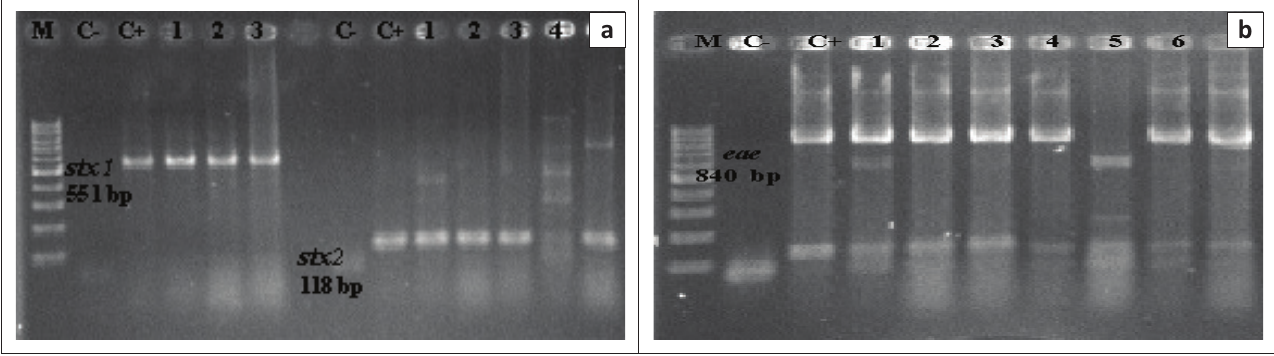
FIGURE 1: Agarose gels electerophoresis of Shiga toxin-producing Escherichia coli isolates. (a) Polymerase chain reaction amplification of the stx1 (551 bp) and stx2 (118 bp) genes. Lanes 1–3, stx1 ; lanes 1–3 and 5, stx2 and (b) polymerase chain reaction amplification of the eae gene (840 bp) (lanes 1–4, 6 and 7). Lane M, 100 bp molecular size markers; Lanes C- and C+, negative and positive control.